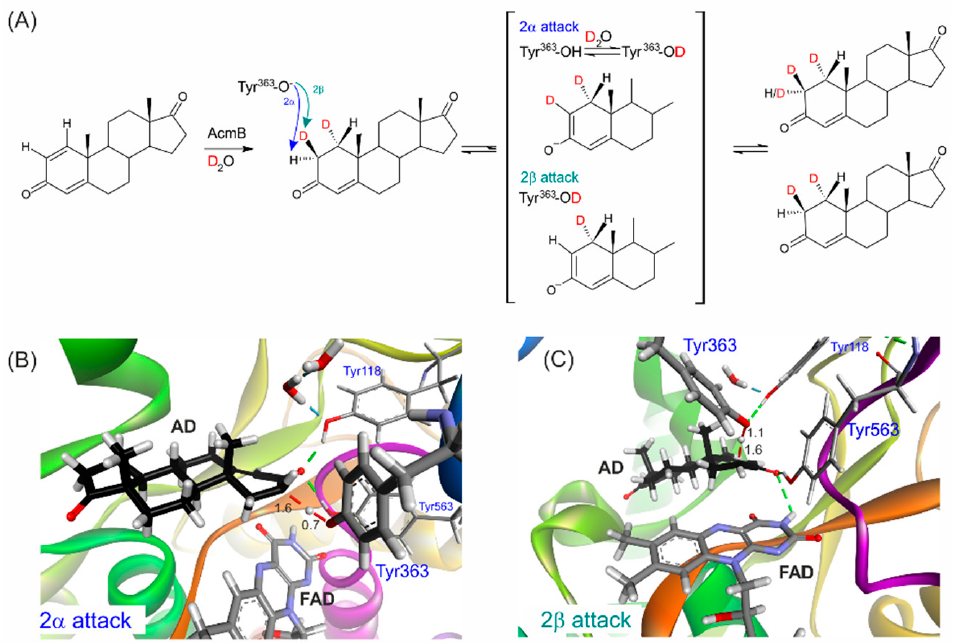
Figure 3. ( A ) 1,2-Hydrogenation of ADD to d 2 -AD in D 2 O followed by isotope exchange at the C2 yielding d 3 -AD. ( B ) Transition state for C2-2 α H abstraction by Y363. ( C ) Transition state for the abstraction of 2 β H-C2 by Y363. The numbers indicate distances in Å, and green dashed lines indicate H-bond interactions.